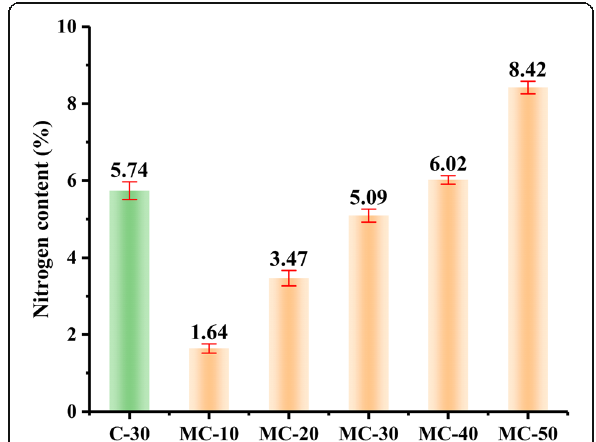
Fig. 5 The nitrogen contents of C-30 and MCF/NR composites